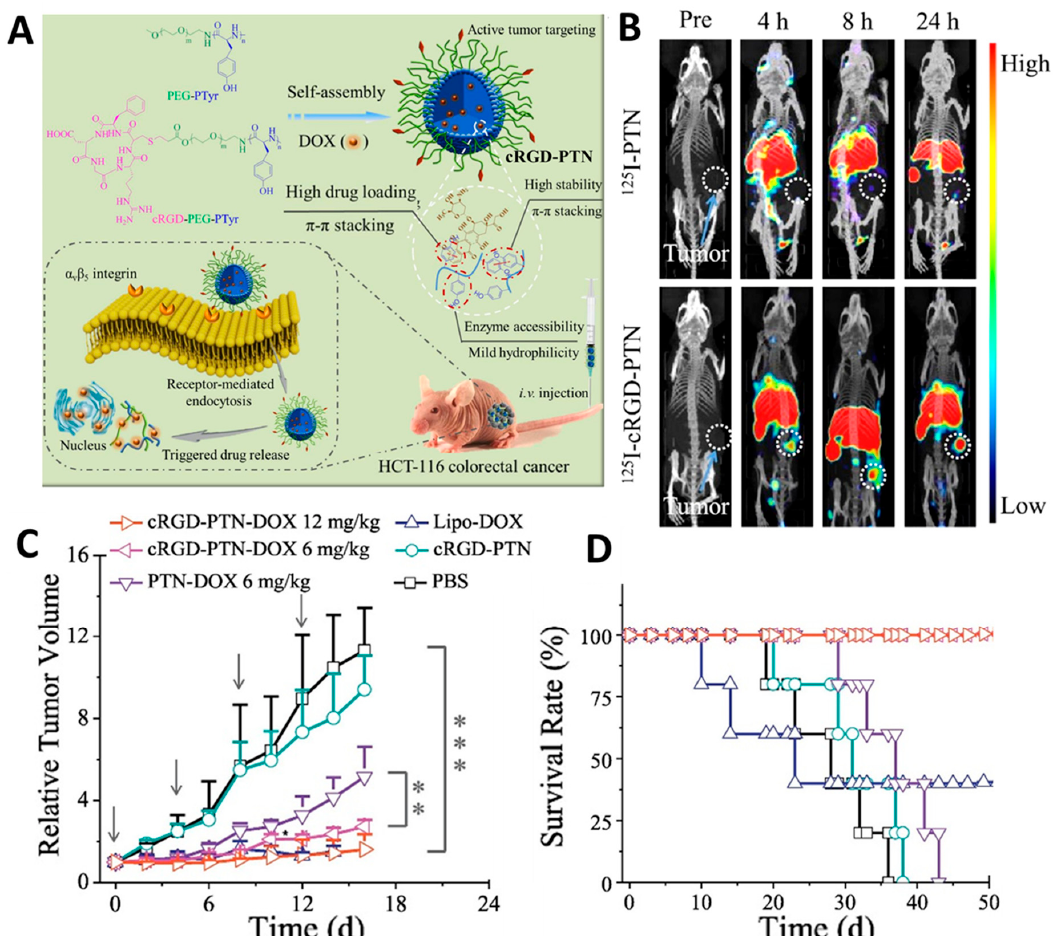
Figure 2. Polytyrosine NP for active cellular targeted delivery of doxorubicin (DOX). ( A ) Illustration of cRGD-decorated polytyrosine (PTyr) nanoparticles (cRGD-PTN) for encapsulation and targeted delivery of DOX to HCT-116 colorectal tumor in mice. cRGD-PTN is co-assembled from PEG-PTyr and cRGD-PEG-PTyr (4/1, mol/mol). DOX is encapsulated in cRGD-PTN through π - π stacking. DOX-loaded cRGD-PTN accumulates in the tumor and is internalized by HCT-116 cells via the cRGD and α ν β 3 integrin receptor-mediated interaction. In HCT-116 cells, PTyr is subject to enzymatic degradation, triggering DOX release and cell death. ( B ) In vivo SPECT/CT images of HCT-116 colorectal tumor-bearing nude mice administered with non-targeted 125 I-PTN and targeted 125 I-cRGD-PTN. Dot circle shows the quantification of 125 I accumulated in tumors over time. Image intensities are shown in color scale in the right. C and D) In vivo therapeutic efficacy of cRGD-PTN-DOX. Tumor volume changes ( C ) and survival rates ( D ) of mice treated with different formulation within 50 days with cRGD-PTN-DOX, PTN-DOX, Lipo-DOX, cRGD-PTN, and PBS, respectively ( n = 6). Figure reproduced from Ref. [48] with permission from Elsevier, 2019.